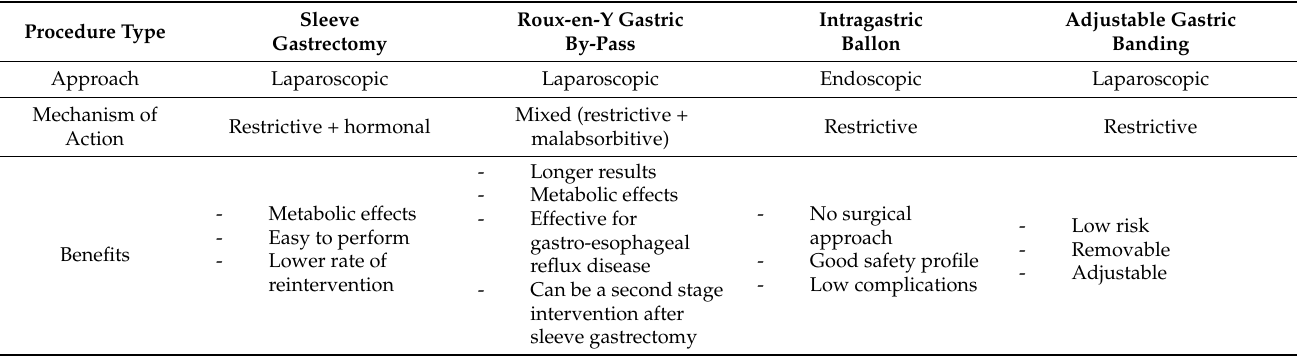
Table 3. Risks and benefits of selected bariatric